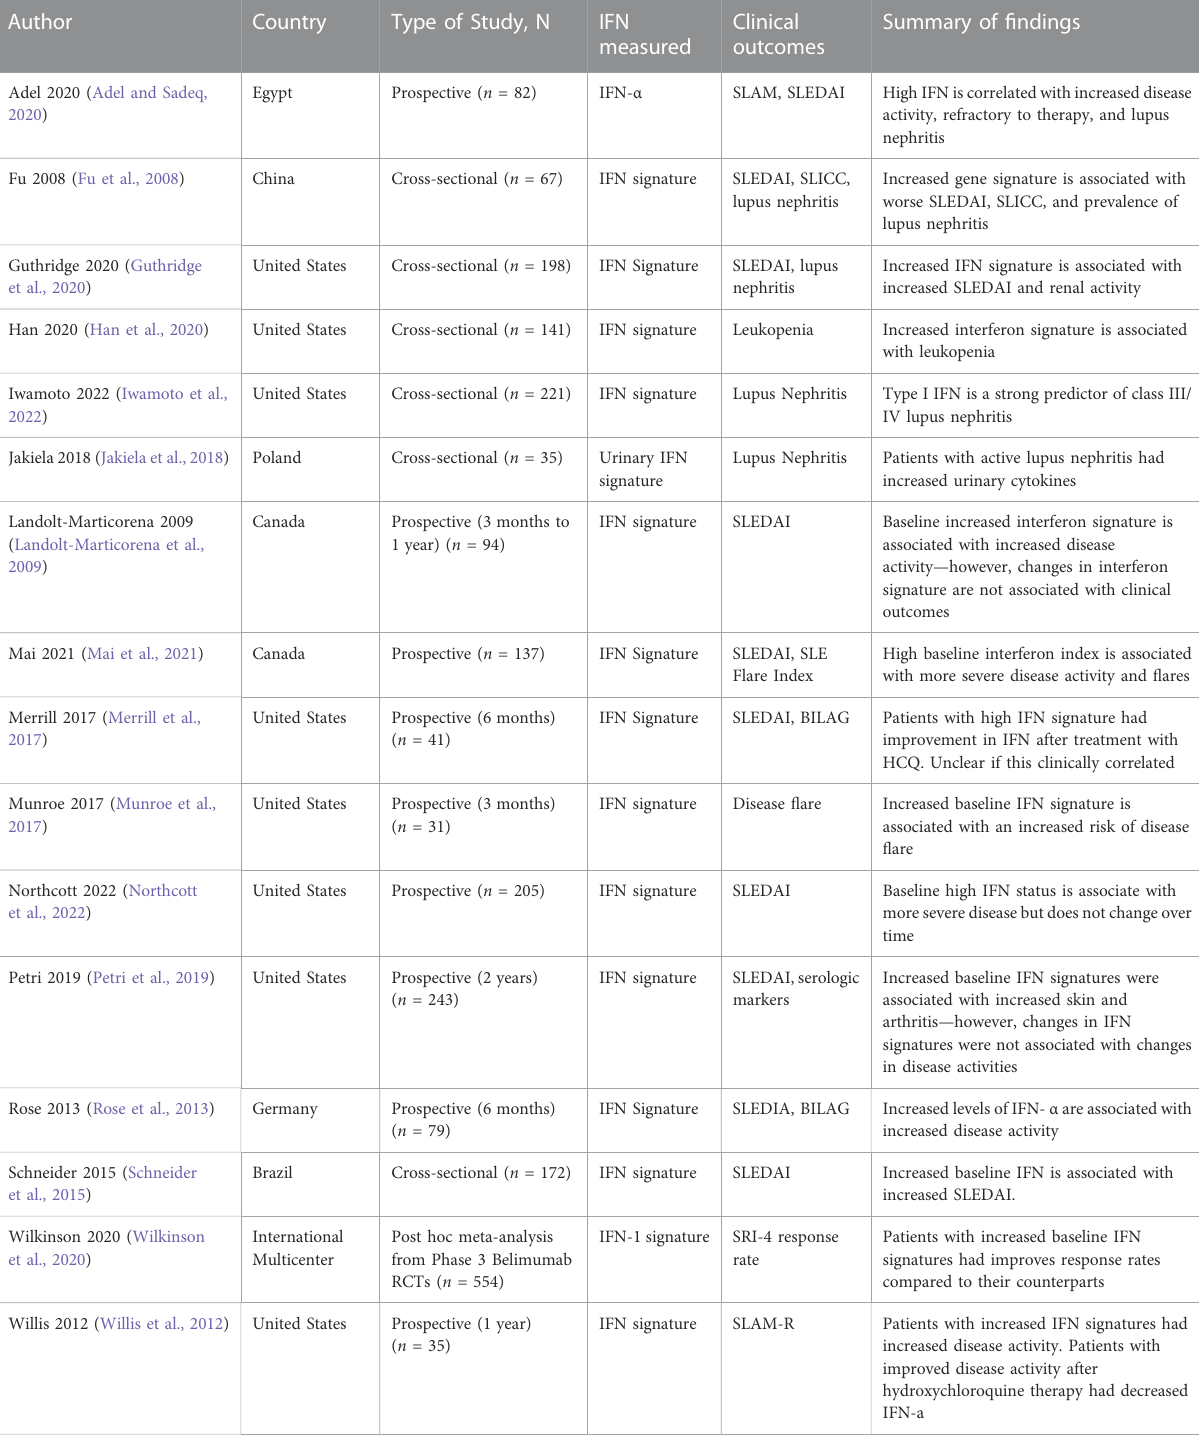
TABLE 1 Selected studies with clinical correlations of interferon signature and